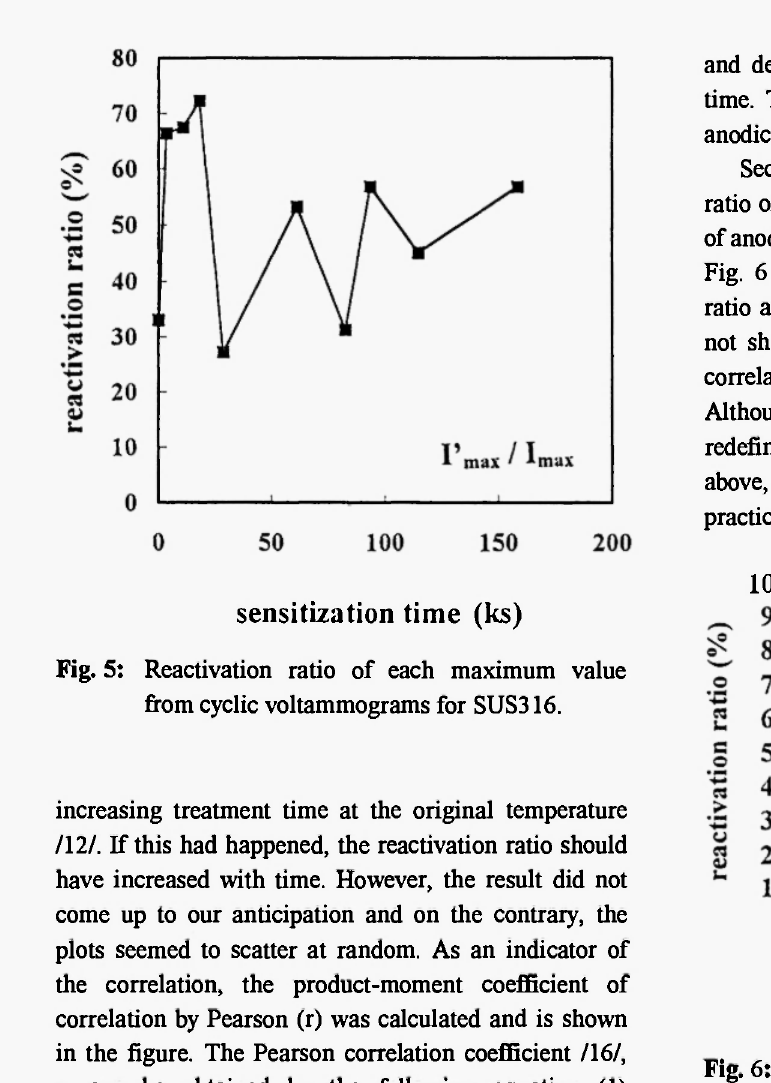
Fig. 6: Reactivation ratio of current densities at 0V from cyclic voltammograms for